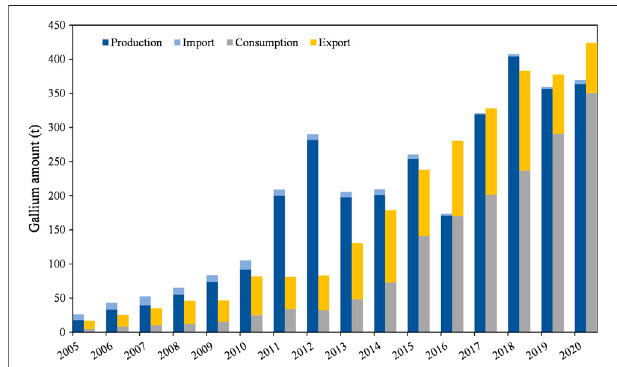
FIGURE 3 | Gallium supply and demand structure in China during 2005 – 2020.